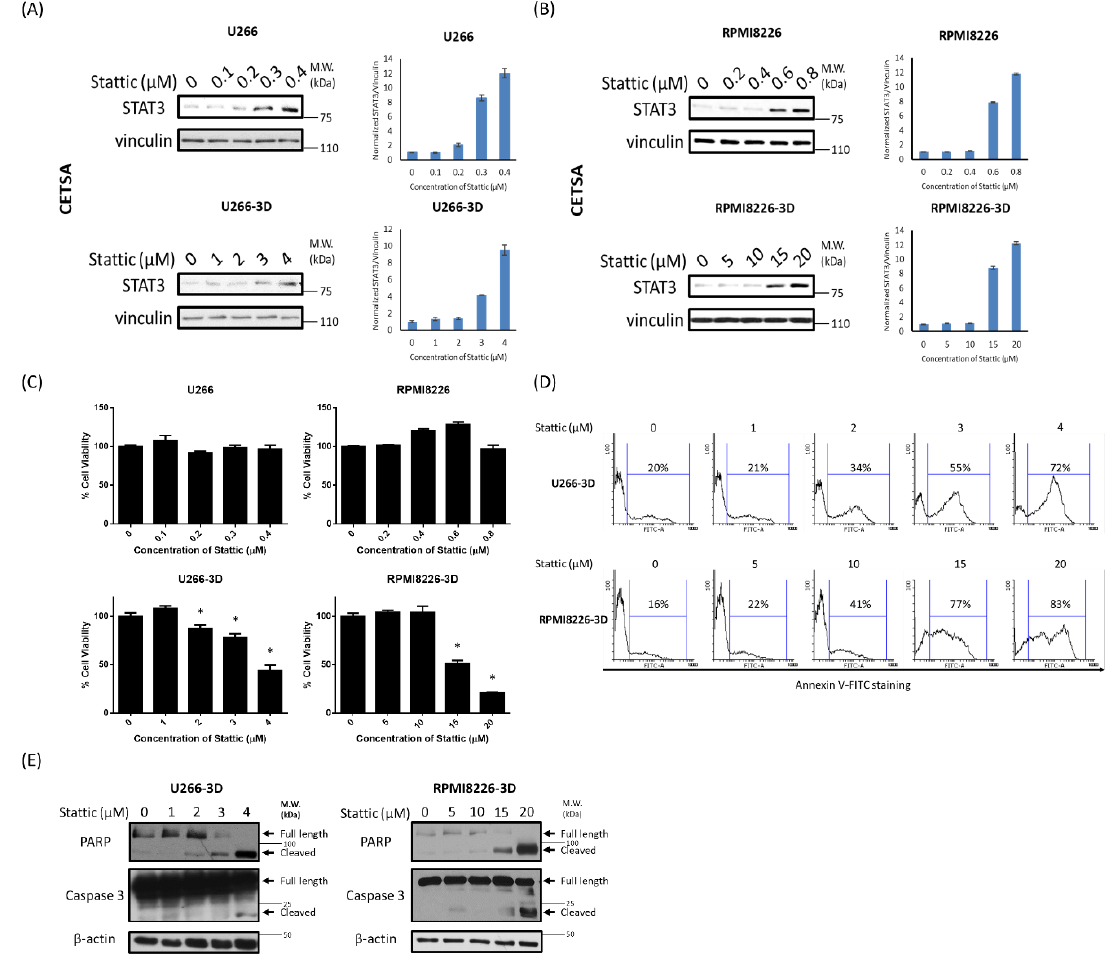
Figure 4. MM cells cultured in 3D are more sensitive to STAT3 inhibition. CETSA of ( A ) U266 and ( B ) RPMI8226 cells in conventional or 3D culture after 1 h of Stattic treatment. Vinculin was blotted as a loading control. The STAT3/vinculin ratios were quantified using ImageJ and shown on the right. Error bars represent the standard deviation from two independent experiments; ( C ) The effect of STAT3 inhibition on cell viability of U266 and RPMI8226 cells in conventional or 3D culture. The cells were treated with Stattic for 24 h. Cell viability was measured by MTS assay and normalized to cells with no Stattic treatment. The error bars represent standard deviation from a triplicate experiment, * p < 0.05, Student’s t -test; ( D ) The effect of STAT3 inhibition on apoptosis in U266- and RPMI8226-3D cells. The cells were treated with Stattic for 24 h and stained with an apoptotic marker Annexin V. The percentage of Annexin V-positive cells was analyzed by flow cytometry; ( E ) The expression levels of two apoptotic markers, cleaved PARP and cleaved caspase 3, in U266- and RPMI8226-3D cells after 24 h of Stattic treatment were examined by Western blot analysis. β -actin was probed as a loading control. For all the experiments above, U266 and RPMI8226 cells were cultured for 2 and 1 days before the Stattic treatment to reach a substantial pSTAT3 level, respectively. 2.5 × 10 5 cells were seeded